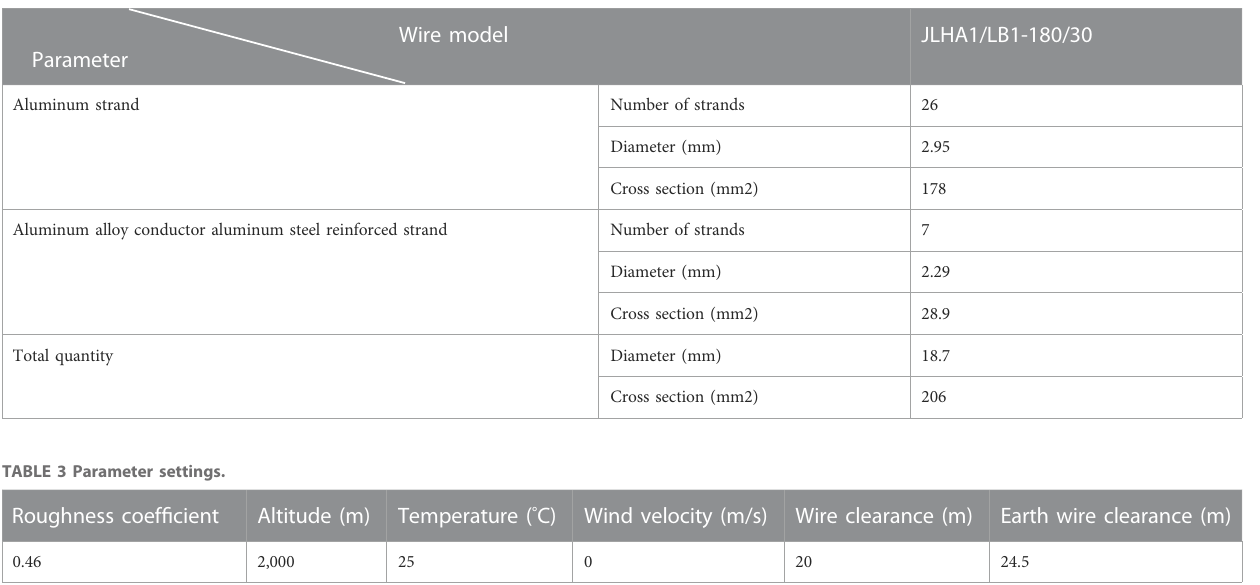
TABLE 2 Earth wire parameters.